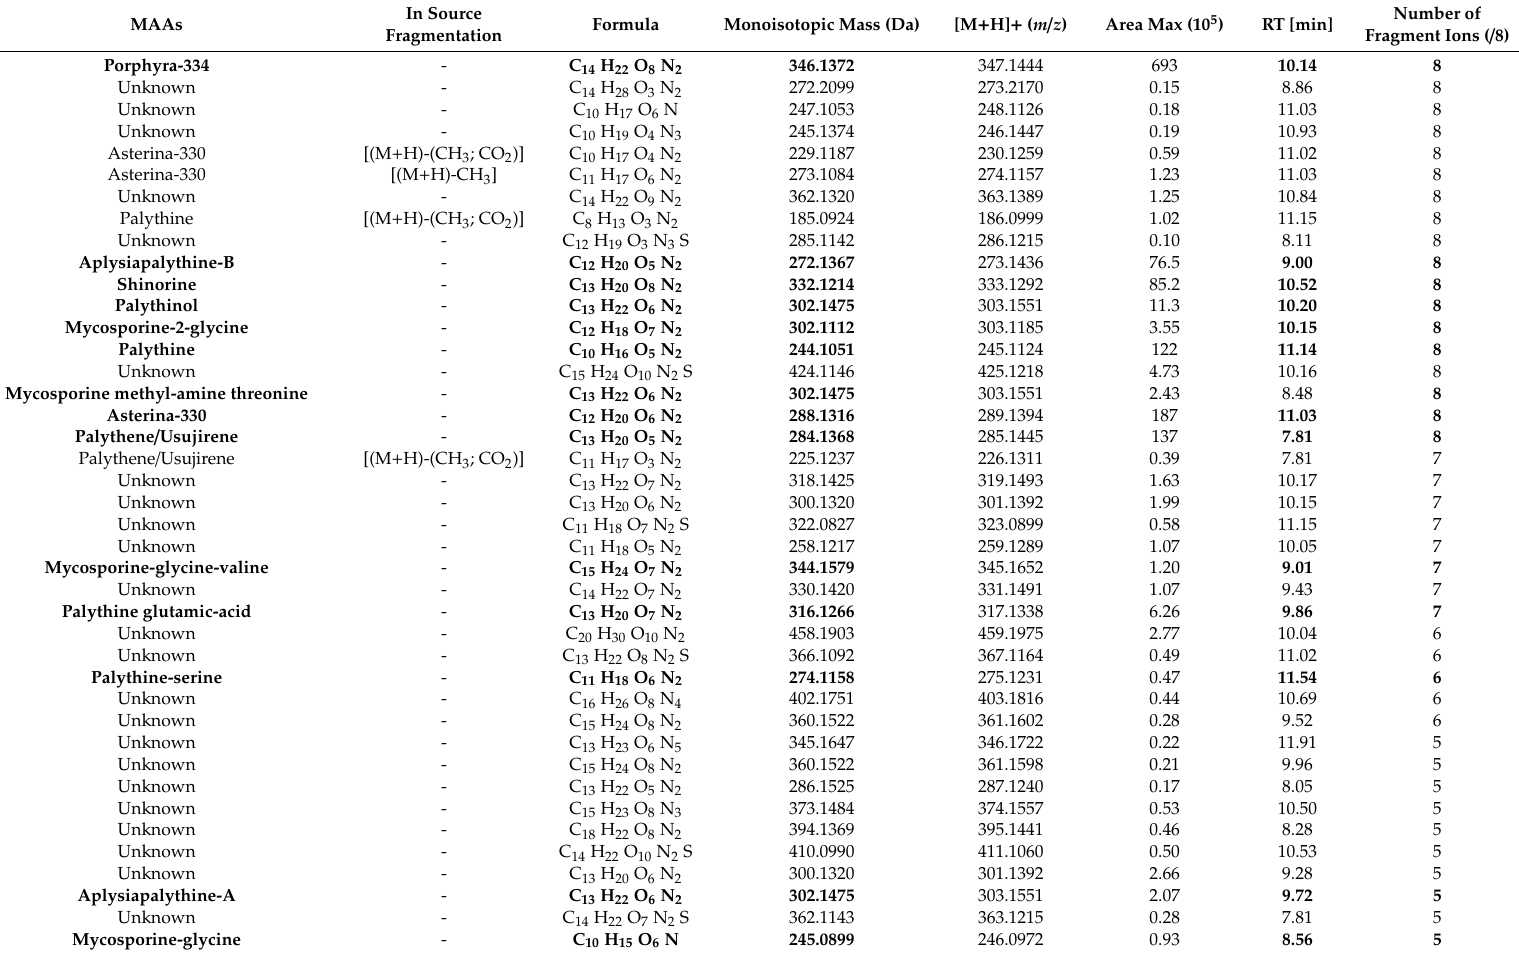
Table 3. Candidate-MAAs detected in the model algae Gymnogongrus devoniensis using the Fragment Ion Search